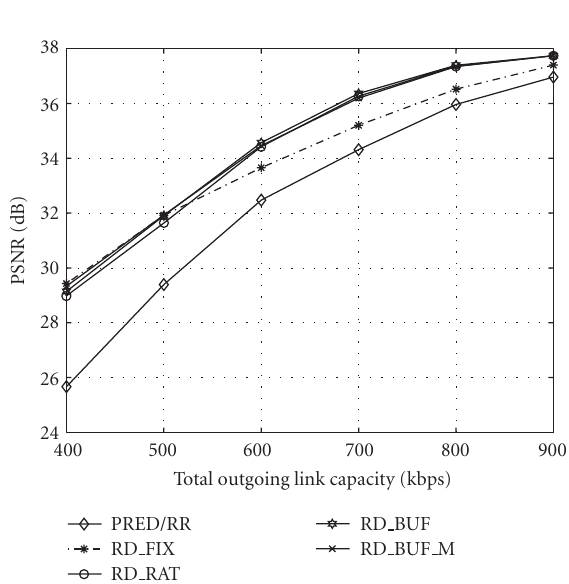
Figure 9: Performance comparison of the proposed RD-optimizer and PRED/RR for streaming and conversational